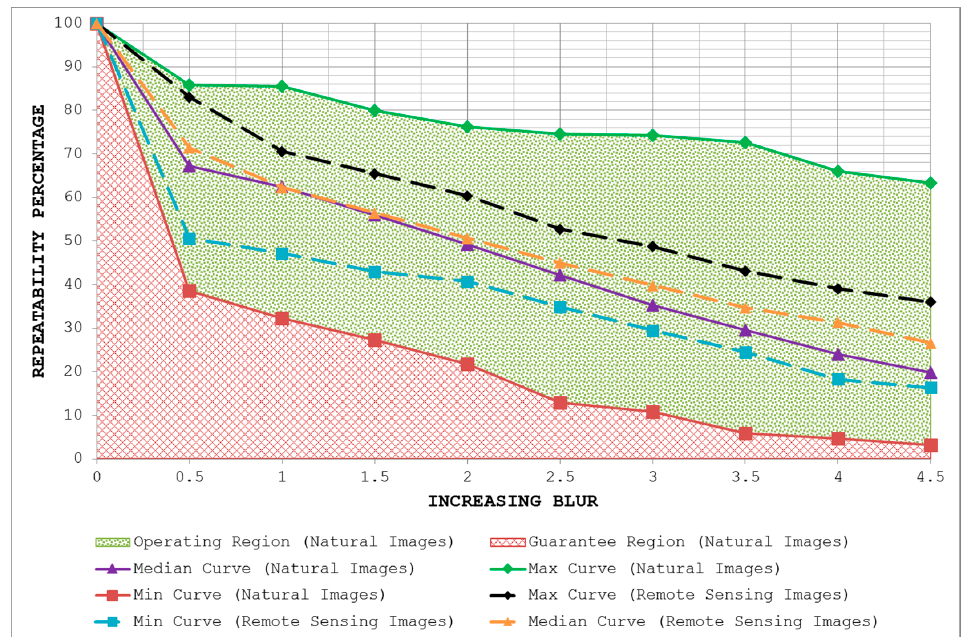
Figure 22. Results of IBR for remote sensing images under increasing blur. The two graphs (natural images and remote sensing images) are overlaid to produce one plot for IBR. Note that although the operating and guarantee regions are defined using the presented database of natural images [50], the curves (median, max and min) in the case of remote sensing images still lie inside the defined operating region and do not cross over to the guarantee region.